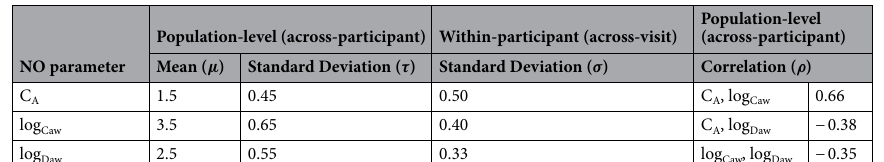
Population-level (across-participant)